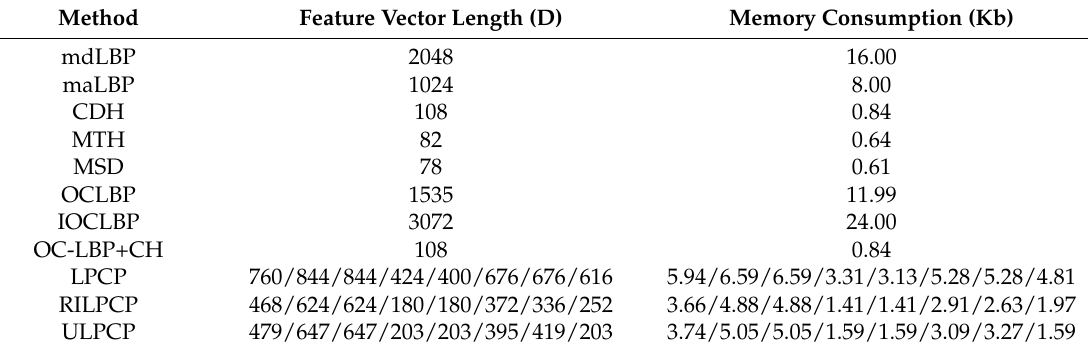
Table 5. Feature vector length (D) and memory consumption (Kb) among the proposed descriptors and other previous